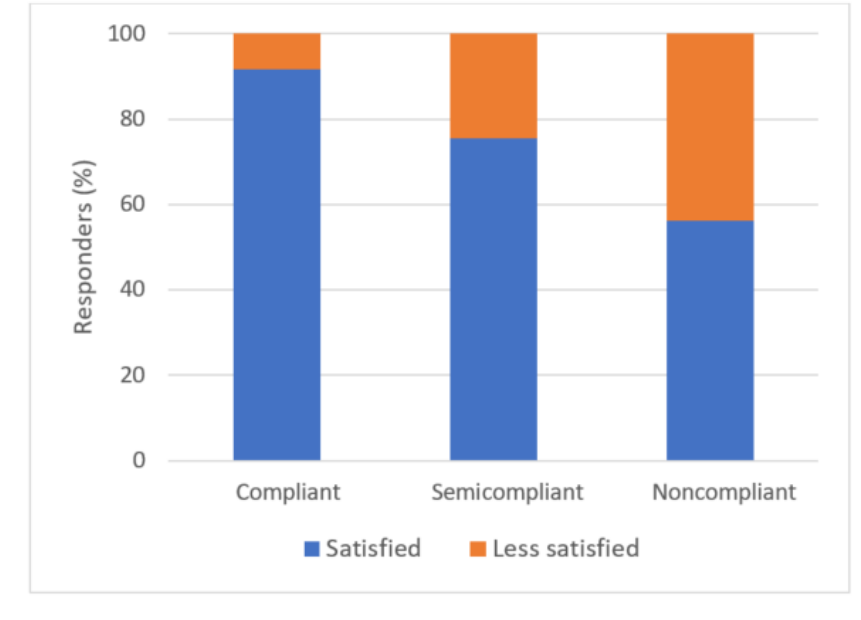
Figure 3. Treatment compliance and satisfaction for the mobile phone automated system